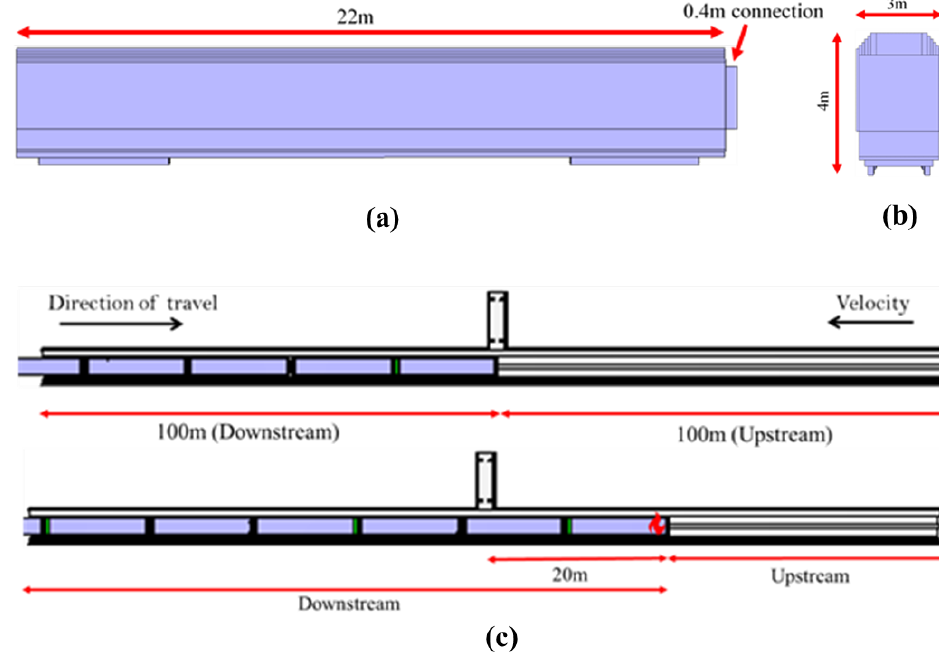
Figure 6. Side view of ( a ) train carriage with a connector and cross-sectional view of ( b ) train geometry front and top view of ( c ) two train locations with respect to the cross-passage.